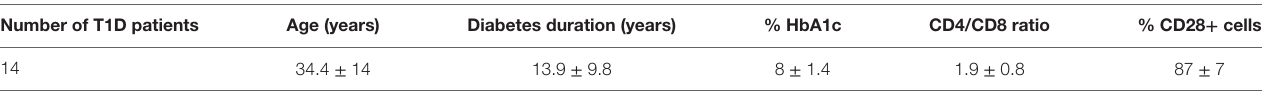
Values indicate mean ± SD. HbA1c, glycated